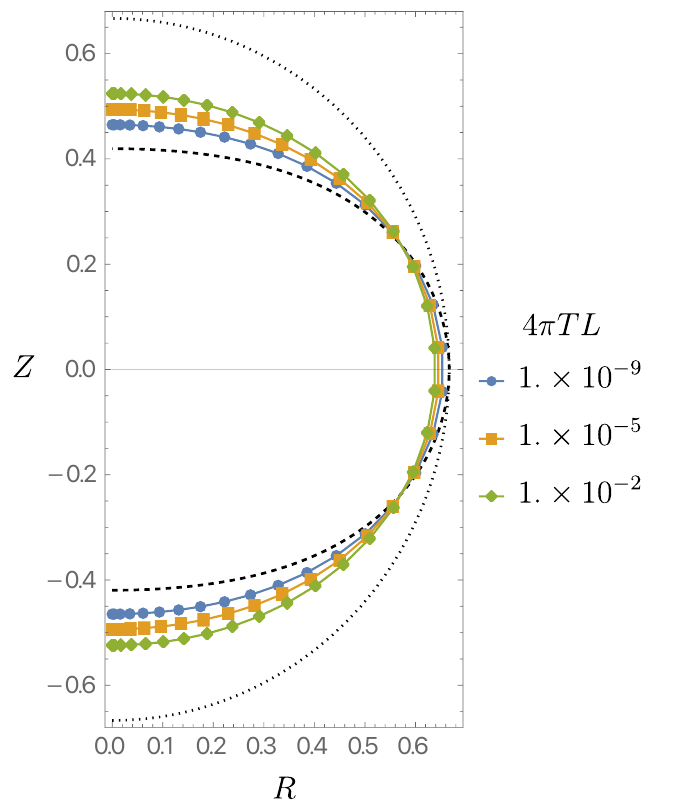
Figure 12 . Isometric embedding of the finite temperature horizon geometry into R 4 . The black dotted line shows what a perfect sphere would look like and the dashed line represents our novel pancaked IR geometry discussed in section 3.2. The several symbols represent the embeddings of our finite temperature solutions, whose temperatures are labeled on the right. The solution with 4 πTL = 10 − 9 has G 5 Q/L 2 ≈ 1 . 33896 , whereas the exact zero temperature solution has G 5 Q/L 2 ≈ 1 . 33653 (corresponding to an agreement of about 0 . 18%